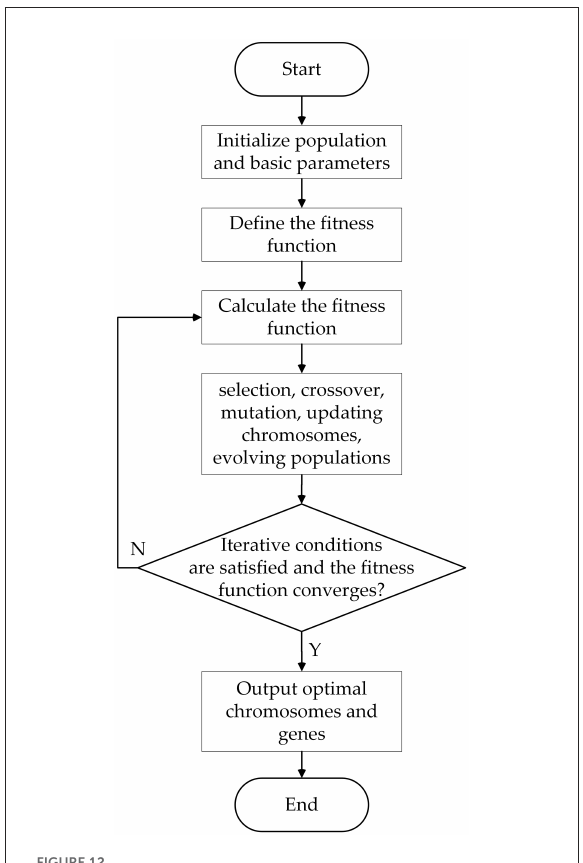
FIGURE12 Optimization process of genetic algorithm.